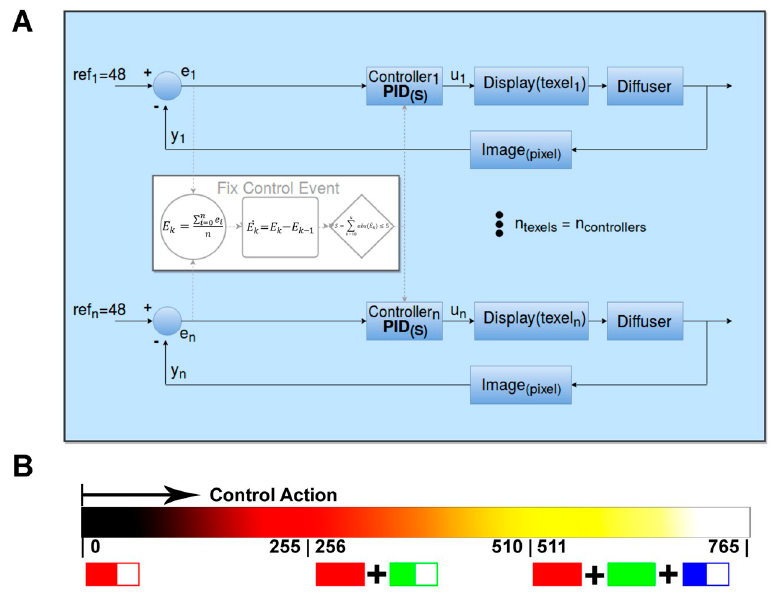
Fig 2. Control principle. A: Control scheme. B: Control action going from black, red, orange, yellow to white, from the minimum level (zero) to the maximum level (255R+255G+255B = 765).